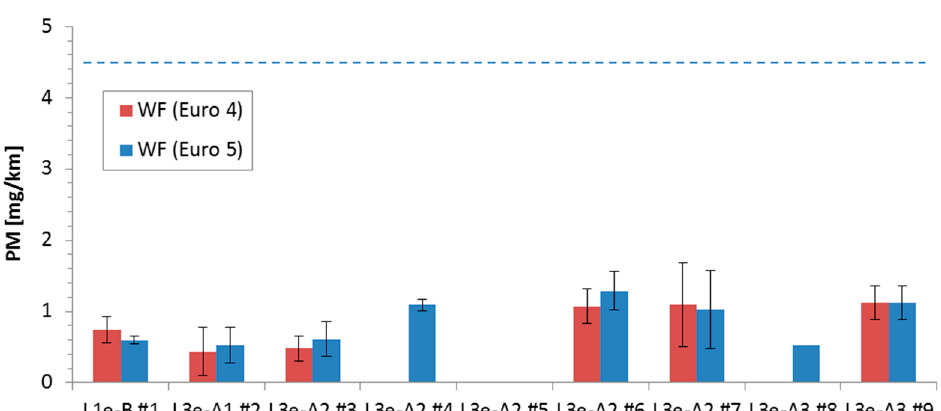
Figure 3. Particulate matter (PM) mass emissions. The cycle tested was the WMTC (Figure 2) with the weighting factors (WF) of Table 2. Exception: L1e-B Euro 4 test cycle was from UNECE Regulation 47. The dashed line shows the PM limit for Euro 5 diesel and gasoline direct injection PTW (and light-duty vehicles). Error bars show min-max values of two repetitions.